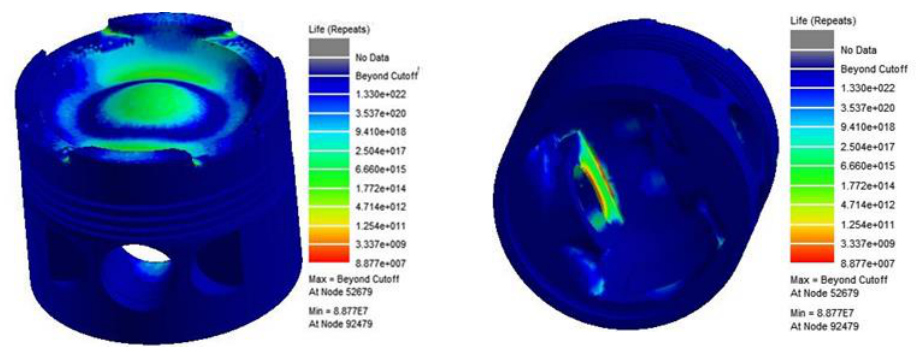
Figure 16. Nephogram of piston fatigue life at different altitudes.